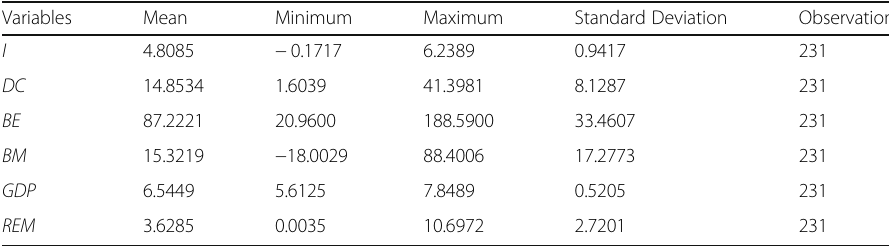
Table 2 Summary statistics of the